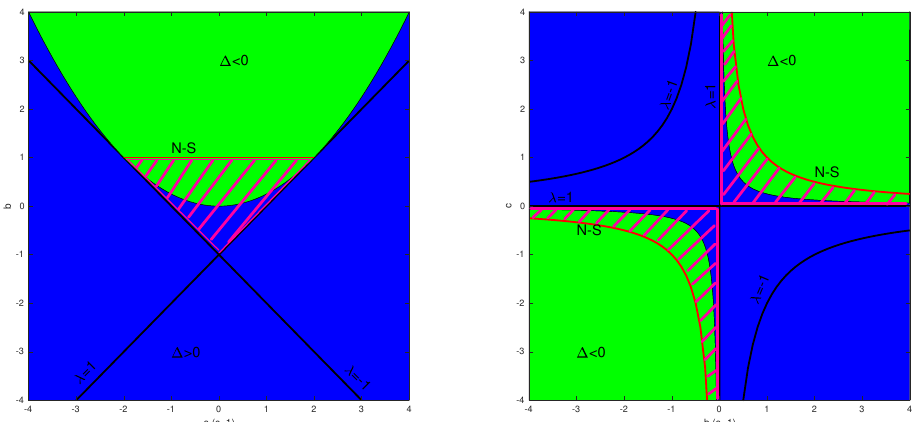
Figure 1. In ( a ) on the left hand side the bifurcation conditions together with the asymptotic stability region of the map in Equation (14) are represented in the plane ( a , b ) with c = 1; In ( b ) on the right-hand side the bifurcation conditions together with the asymptotic stability region are represented in the plane ( b , c ) with a = 1. The green area corresponds to complex eigenvalues, the blue one to real eigenvalues; the black lines denote the flip and fold bifurcation, the red line marks the Neimarck Sacker bifurcation and the striped area characterizes the asymptotic stability region.